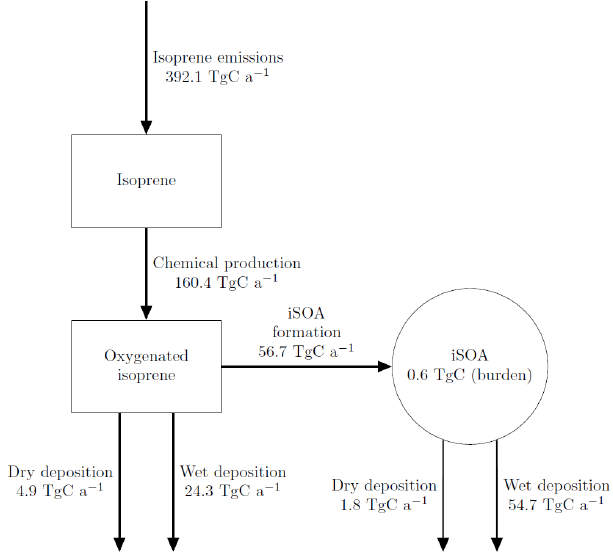
Figure 4. Global budgets for isoprene-derived secondary organic aerosol and its precursors (sources and sinks in TgCa − 1 and bur- den in TgC) predicted by the ECHAM–HAMMOZ reference sim- ulation for 2012. For details about the individual compounds see Table